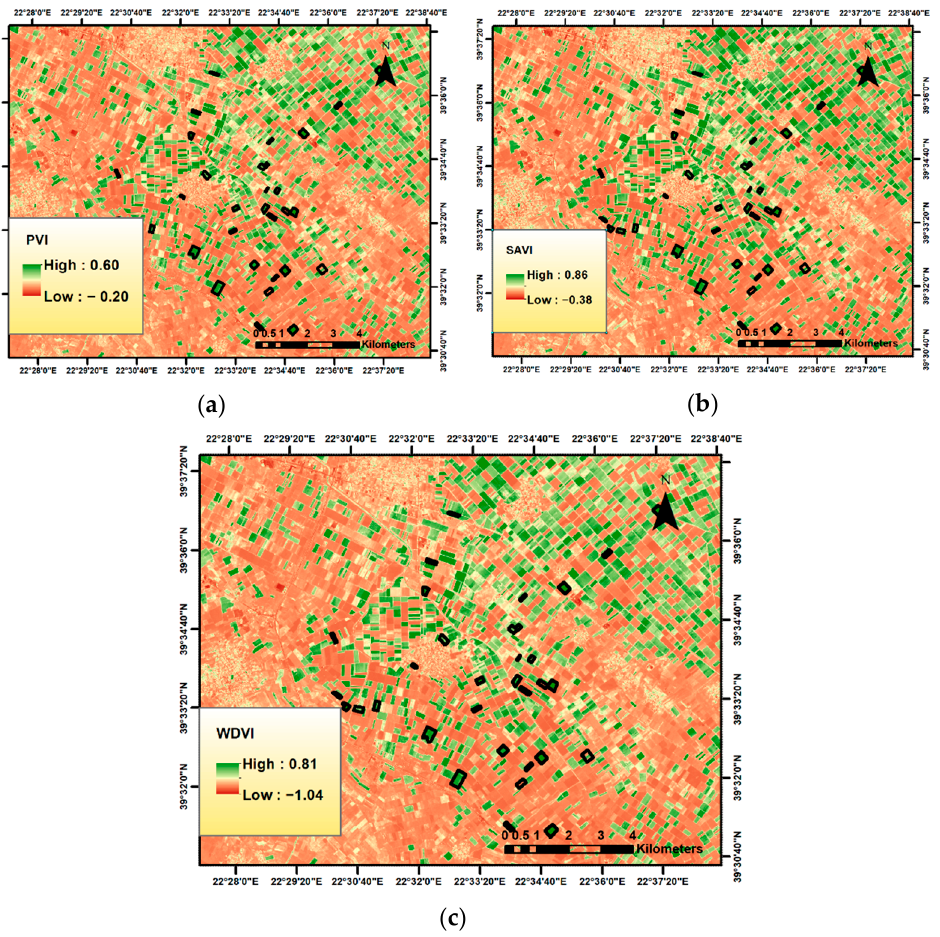
Figure 3. A segment of the study area in the wider area of Larissa: ( a ) PVI; ( b ) SAVI; ( c ) WDVI.